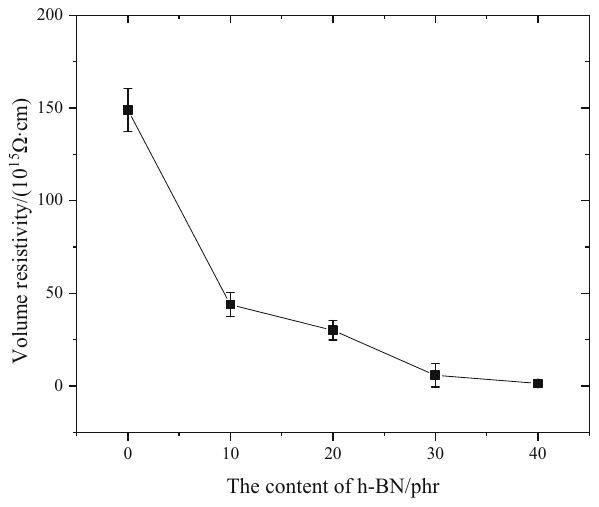
Figure 6: Volume resistivity of EP composites with di ff erent h - BN